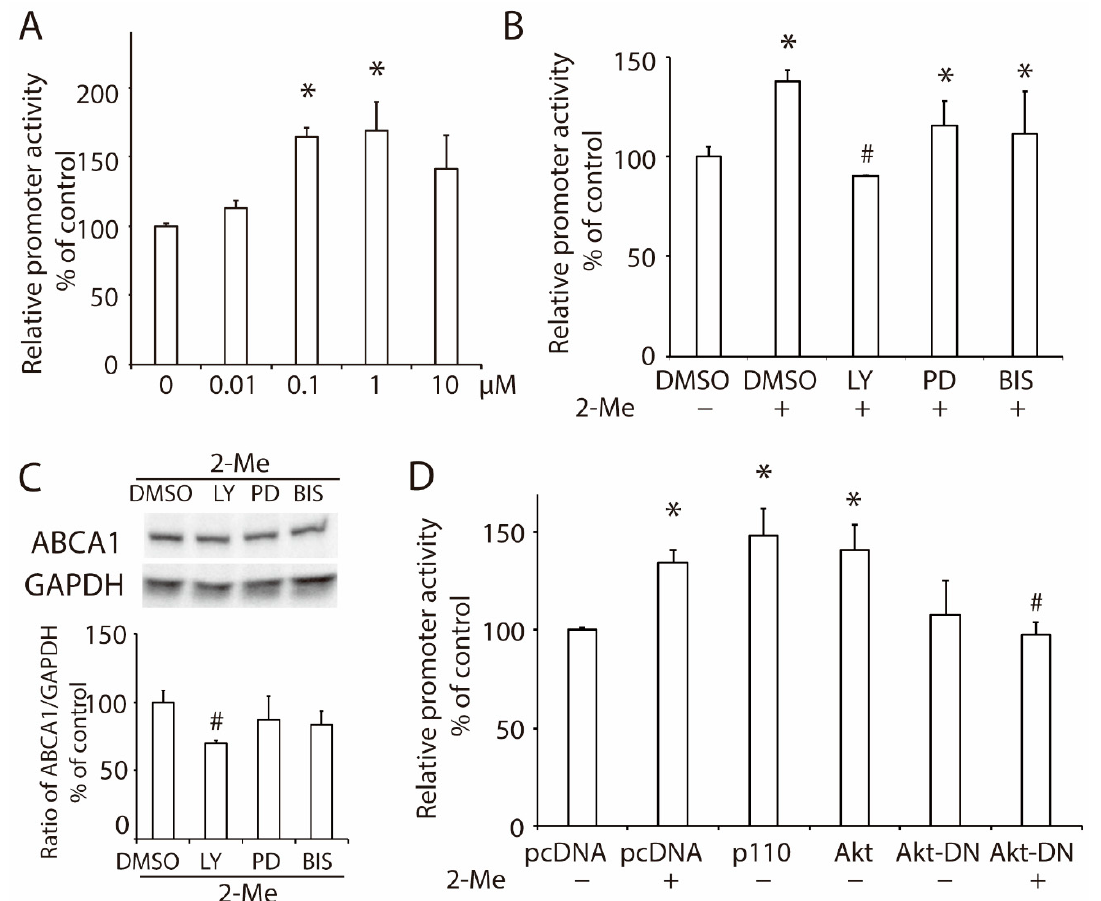
Figure 2. 2-ME 2 enhances the promoter activity of ABCA1 via the PI3K/Akt signaling pathway. ( A ) ABCA1 promoter activity in HepG2 cells treated with 2-ME 2 at varying doses for 24 h. ( B ) Effects of a PI3K inhibitor LY294002 (LY), an MEK/ERK inhibitor PD98059 (PD), or a PKC inhibitor bisin- dolylmaleimide I (BIS) on 2-ME 2 -induced ABCA1 promoter activity in HepG2 cells. ( C ) Protein expression of ABCA1 in HepG2 cells treated with 2-ME 2 with or without LY, PD, or BIS. ( D ) Role of the PI3K/Akt pathway on ABCA1 promoter activity induced by 2-ME 2 . pcDNA, control vector; p110, overexpression of the p110 catalytic subunit of PI3K; Akt, overexpression of Akt; Akt-DN, domain-negative Akt. Each data shows the mean ± SEM ( n = 3) of separate experiments for each group. * p < 0.05 compared to control or pcDNA; # p < 0.05 compared to 2-ME 2 .